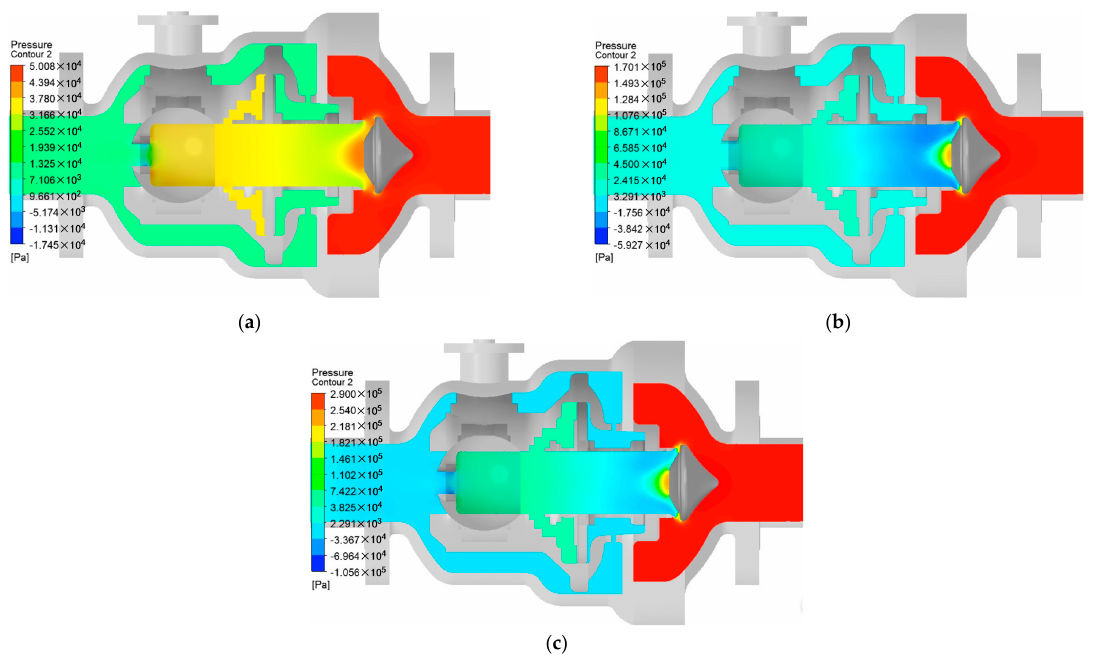
Figure 11. Pressure field of dynamic flow balance valve. ( a ) ∆ P = 30 kPa, the 0 s moment of the moving mesh. ( b ) ∆ P = 150 kPa, the 0.26 s moment of the moving mesh. ( c ) ∆ P = 270 kPa, the 0.53 s moment of the moving mesh.